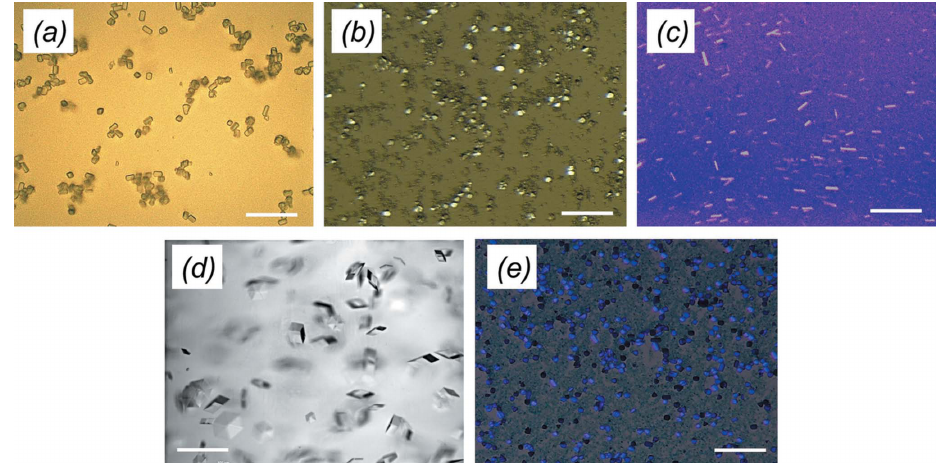
Figure 1 Protein microcrystals at ALBA, showing ( a ) lysozyme, ( b ) proteinase K, ( c ) (cid:2) -spectrin-SH3, ( d ) insulin and ( e ) phycocyanin. The scale bar represents 100 m m.